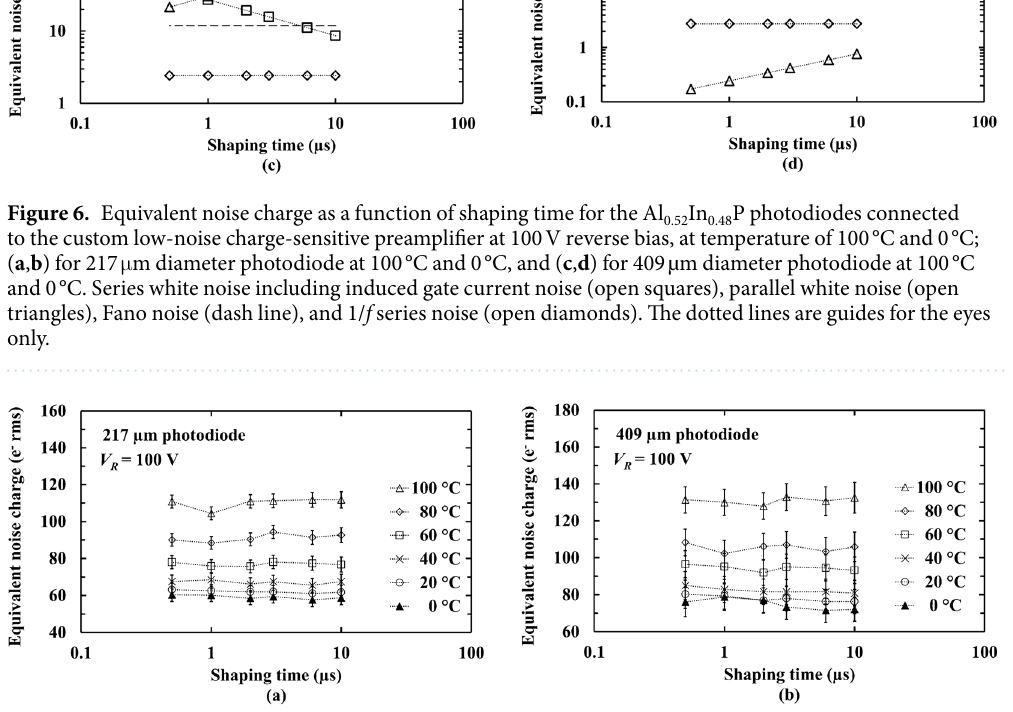
Figure 7. Equivalent noise charge of the dielectric noise as a function of shaping time for the ( a ) 217 μ m and ( b ) 409 μ m diameter Al 0.52 In 0.48 P photodiode X-ray spectrometers at 100 V reverse bias, at different temperatures. 100 °C (open triangles); 80 °C (open diamonds); 60 °C (open squares); 40 °C ( × symbols); 20 °C (open circles); 0 °C (dark triangles). The dotted lines are guides for the eyes only.